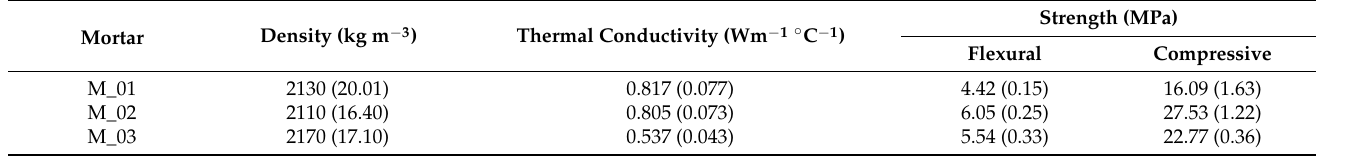
Table 1. Thermal and mechanical properties of the screed mortars: average values (standard devi- ation).